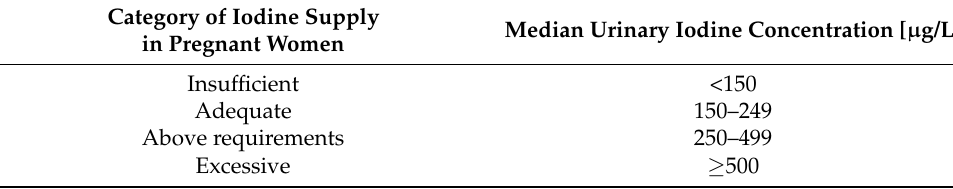
Table 1. Median UIC categories in pregnant women according to the WHO